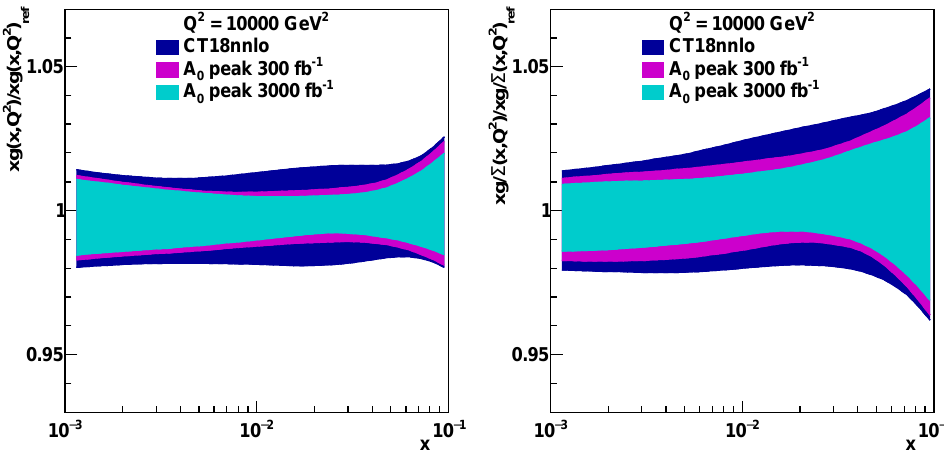
Figure 1: The gluon ( x g ) and gluon / Sea ( x g / Σ ) PDFs in the original CT18NNLO analysis (blue) and profiled using A pseudodata corresponding to integrated lumi- 0 nosities of 300 fb − 1 (magenta) and 3 ab − 1 (cyan) in the region 80 GeV < M < 100 GeV and | Y | <